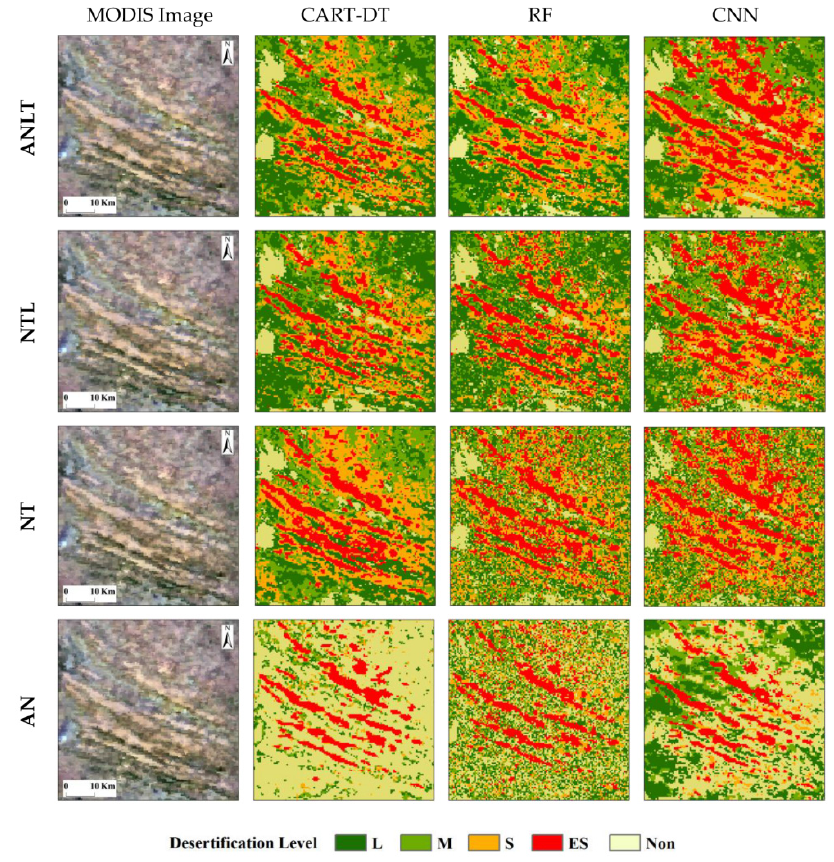
Figure 5. The desertification land classification results of the typical region based on different indicators and different machine learning methods with corresponding satellite images (see Figure 1 for the location of the typical region). L—light desertification, M—moderate desertification, S—severe desertification, ES—extremely severe desertification, Non—non-desertification. Table 4. The landscape indices of desertification land based on different combinations.